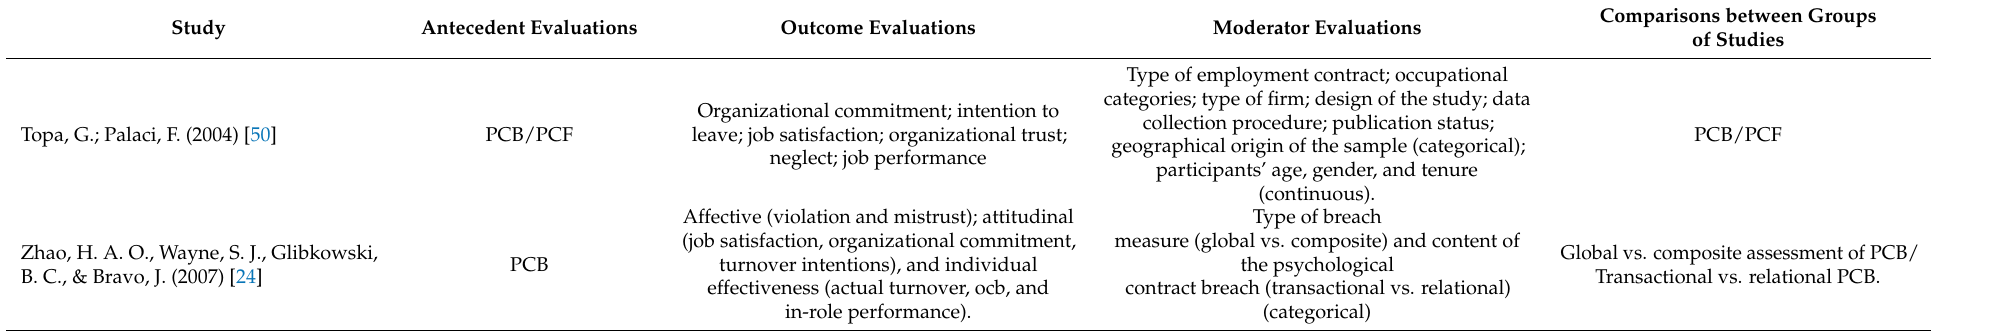
Table 5. Antecedent, outcome, and moderator variables analyzed by the included reviews and